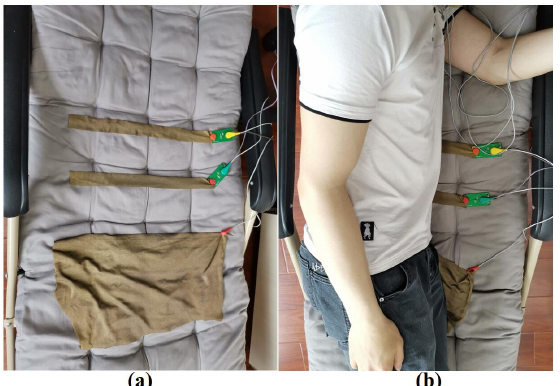
Figure 13. Experimental setups in side lying posture: ( a ) before the subject side lied on the recliner, ( b ) the subject was side lying on the recliner.